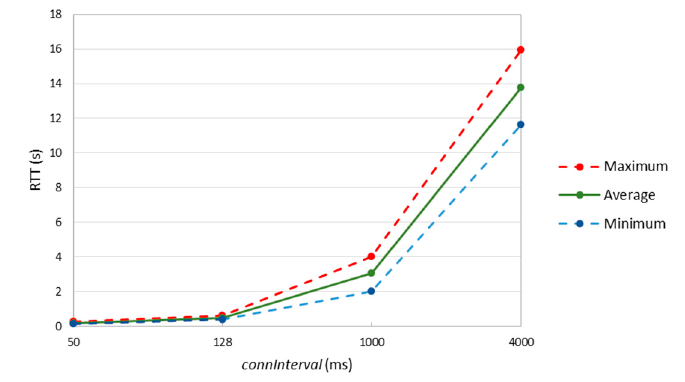
Figure 8. Measured IPv6 packet RTT results over a two-hop topology.